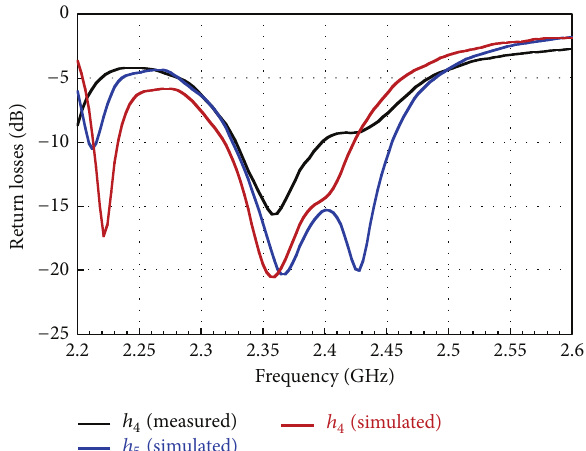
Figure 17: Return losses (antenna with softened edges).